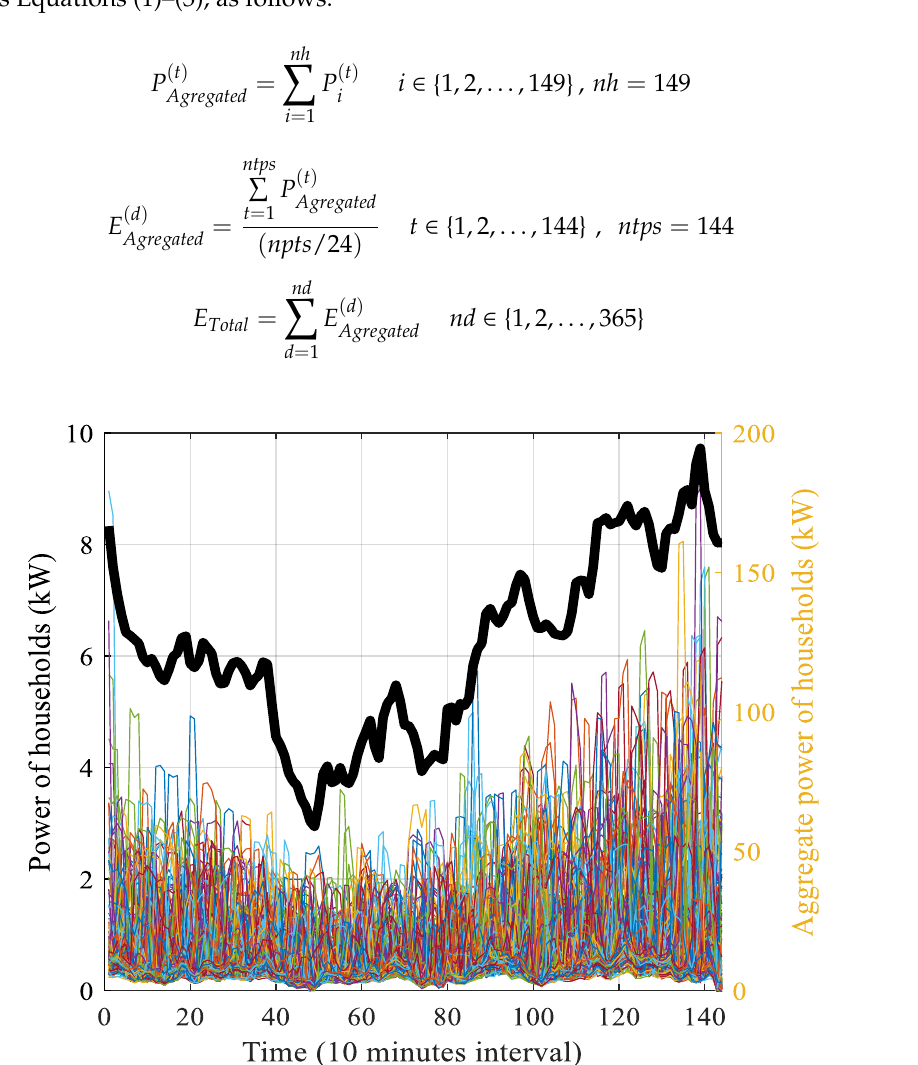
Figure 2. Typical daily residential load profile in Malaysia.